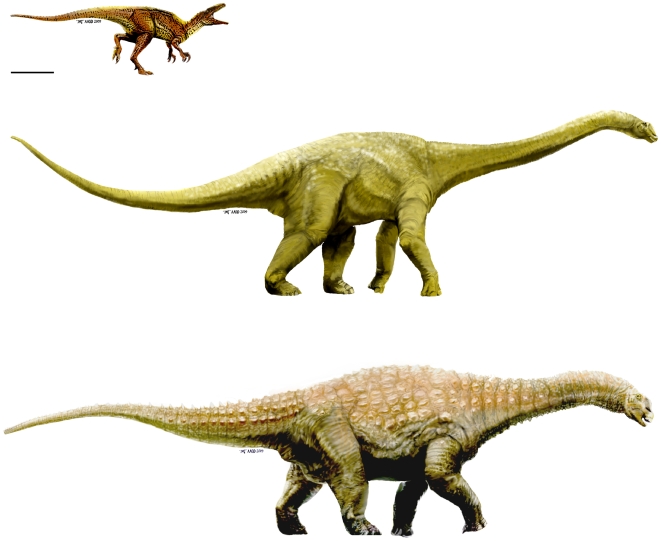
Reconstructions of Diamantinasaurus matildae, Wintonotitan wattsi, and Australovenator wintonensis.
Artistic representations of the three dinosaur taxa described here. Australovenator (top); Wintonotitan (middle); Diamantinasaurus (bottom). Artwork by: T. Tischler, Australian Age of Dinosaurs Museum of Natural History.